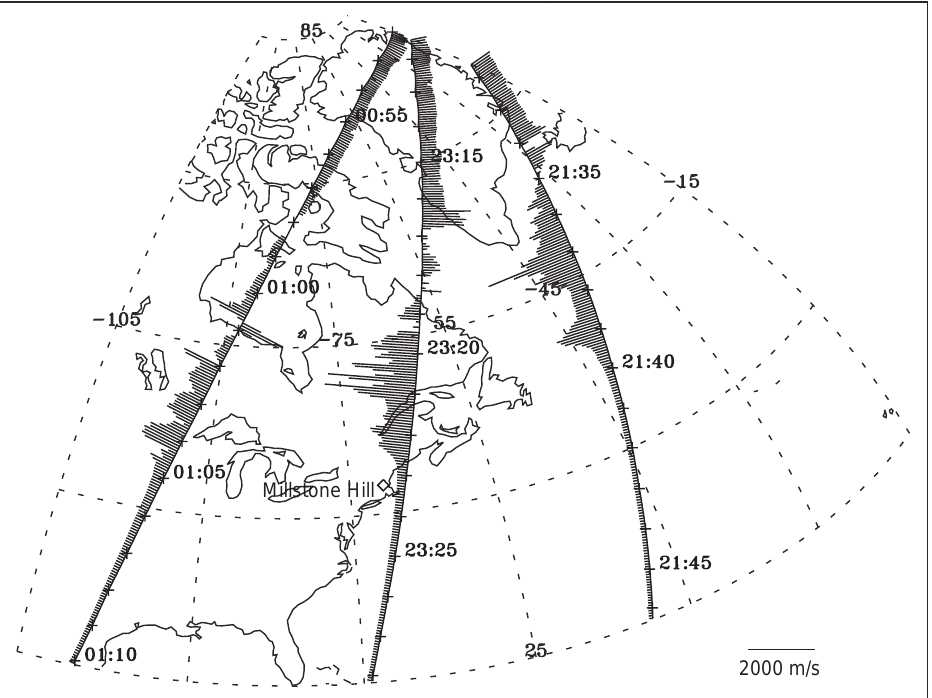
Fig. 12. DMSP F8 satellite measurements of the horizontal ion drift velocities (perpendicu- lar to the satellite’s travel path) during a number of passes in the 18 LT meridional plane near the time studied. UT tick marks as shown along the